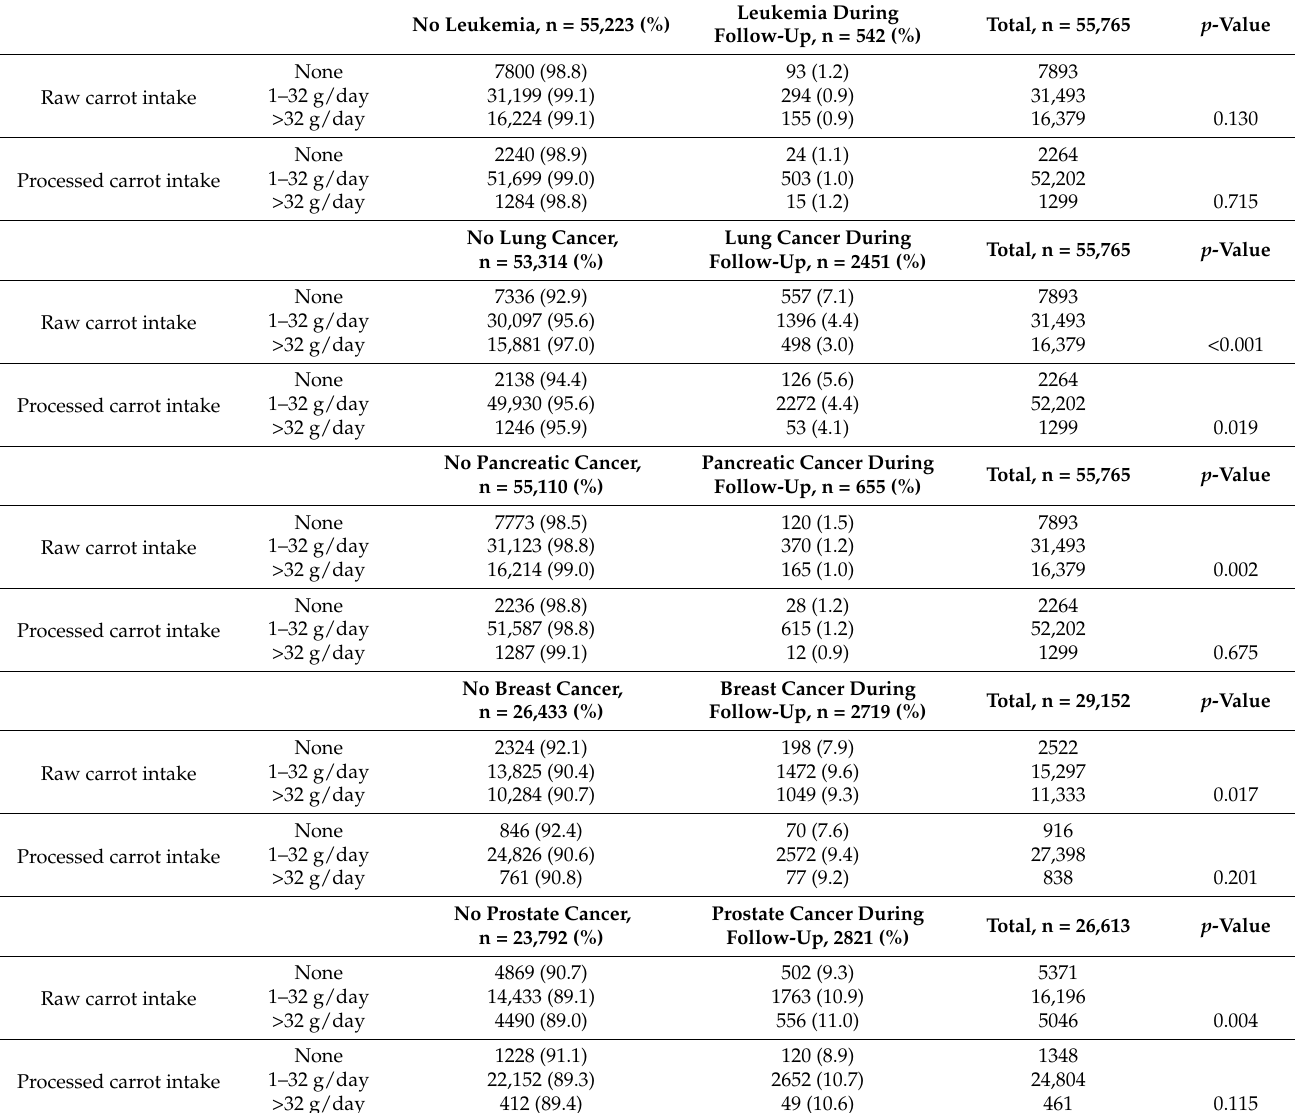
Table 2. Baseline carrot intake by outcomes during follow-up. Leukemia During No Leukemia, n = 55,223 (%) Total, n = 55,765 p Follow-Up, n = 542 (%)